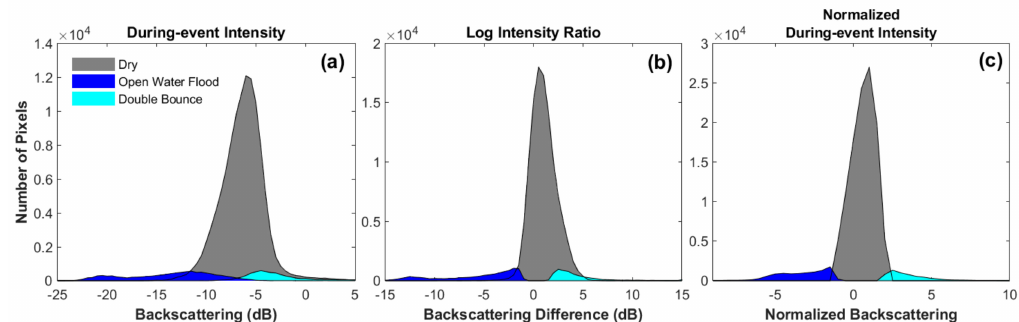
Figure 9. The histogram comparison between the pixels in the Dry class and mapped as nonflooded (grey), Flood class and mapped as flooded with intensity decrease (cyan, interpreted as open water flood), and Flood class and mapped as flood with intensity increase (cyan, interpreted as double bounce scattering). ( a ) Histogram for the pixel during-event intensity. ( b ) Histogram for the pixel log intensity ratio. ( c ) Histogram for the pixel during-event intensity after time-series normalization.